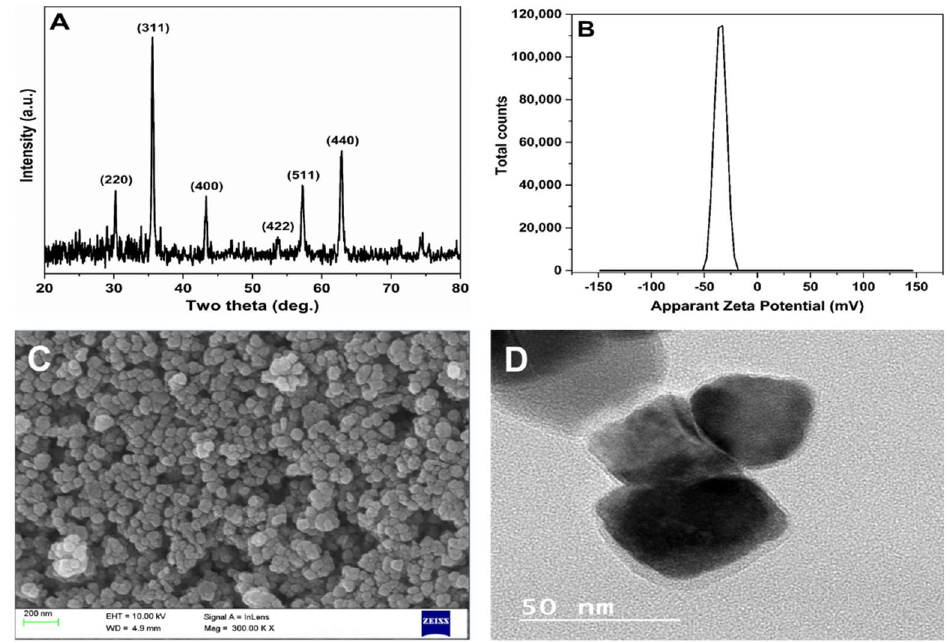
Figure 1. Characterization of FFGN ( A ) XRD, ( B ) Zeta potential, ( C ) SEM, ( D )